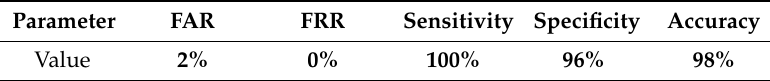
Table 3. Measured parameters of the proposed